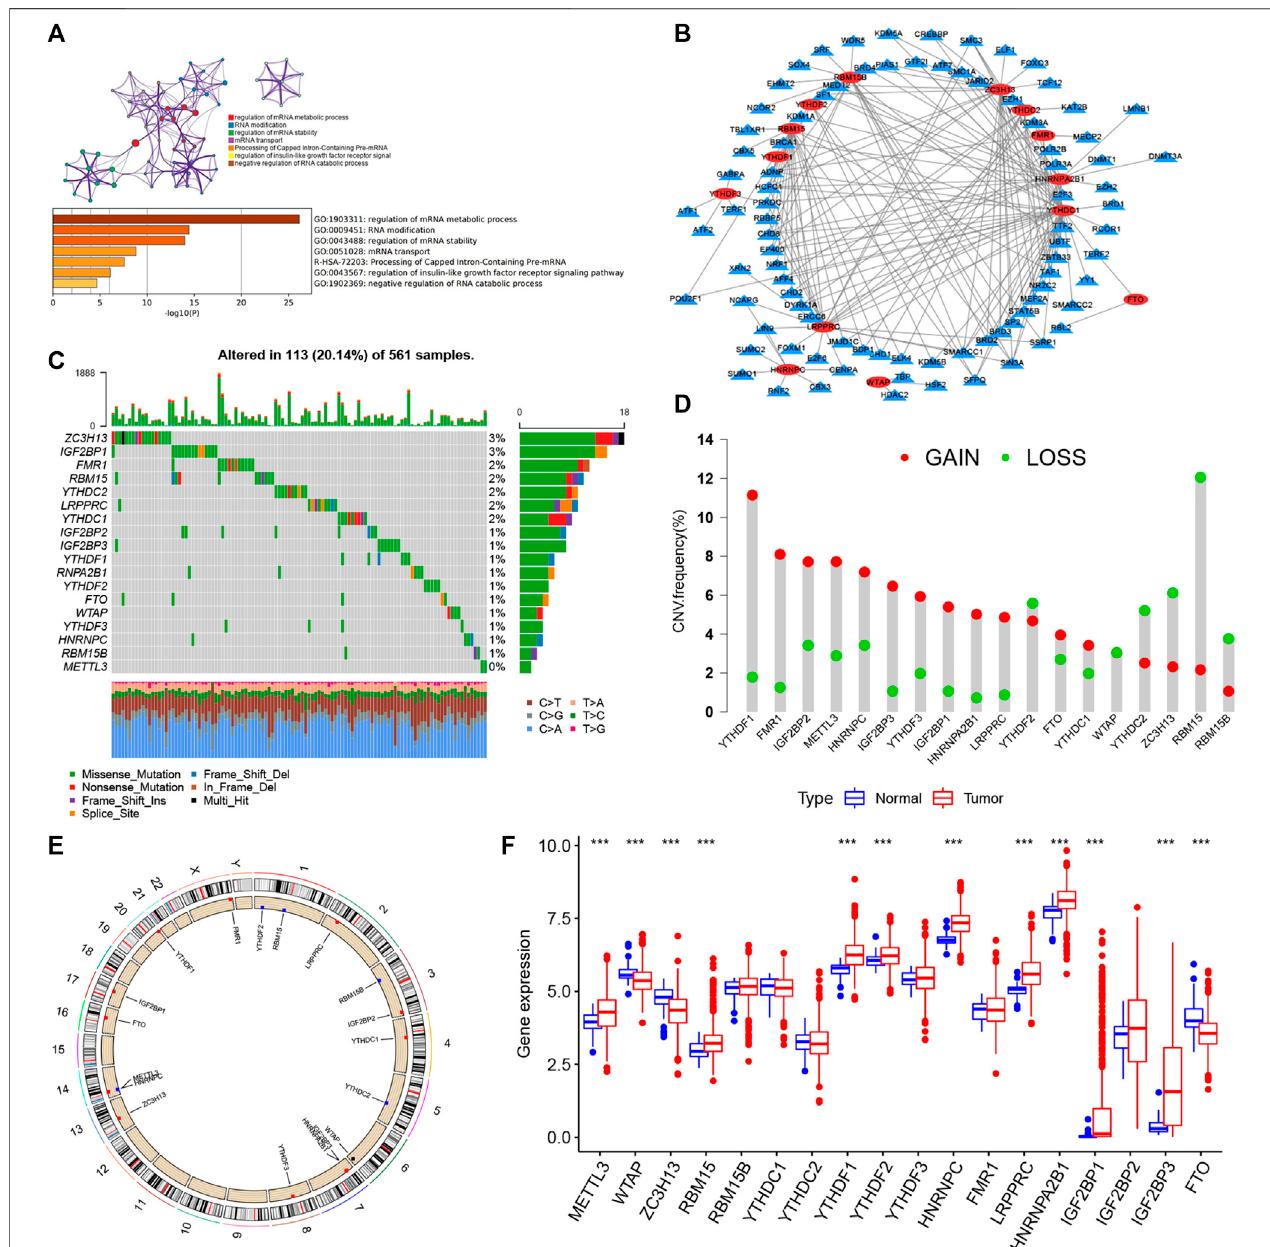
FIGURE1| Landscapeofgeneticandexpressionvariationofm6AregulatorsinLUAD. (A) Metascapeenrichmentnetworkandheatmapofenrichmentitemsinthe input gene list colored with p value. (B) Determination of transcription factors related to 23 m6A regulatory factors by Pearson ’ s correlation analysis (|Cor| > 0.5 and p < 0.001). (C) Mutation frequency of 23 m6A regulatory factors in 561 LUAD patients in TCGA – LUAD cohort. Each column represents an individual patient. The abovementioned barplot is TMB, and the number on the right represents the mutation frequency of each regulatory factor. The barplot on the right shows the proportionofeachvariationtype.Thestackedbarplotbelowshowsthetransformationsectionineachexample. (D) CNVvariationfrequencyofm6Aregulatoryfactorsin TCGA – LUAD cohort. The height of the column represents the frequency of change. Delete frequency, green dot; ampli fi ed frequency, red dot. (E) Location of CNV change of m6A regulatory genes on 23 chromosomes by TCGA – LUAD cohort. (F) Expression of 23 m6A regulatory factors in normal and LUAD tissues. Tumors, red; normal,blue.Theupperandlowerendsoftheboxrepresentthequartilerangeofvalues.Thelinesintheboxrepresentintermediatevalues,andtherealpointsrepresent outliers. The asterisk represents the statistical p value. (* p < 0.05; ** p < 0.01; *** p < 0.001).